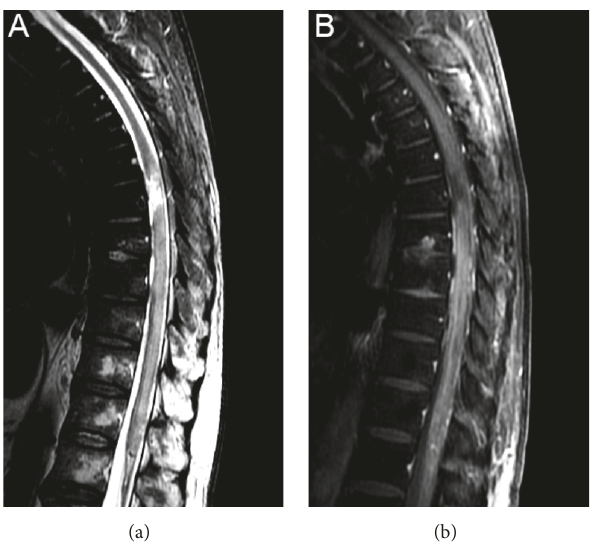
Figure 1: Spinal cord magnetic resonance imaging. Sagittal T2-weighted MRI shows a high signal intensity lesion on T6-T7 levels and a longitudinally extensive tumefactive hyperintense lesion from T6 to the medullary cone (a) with enhancing on postcontrast series (b).